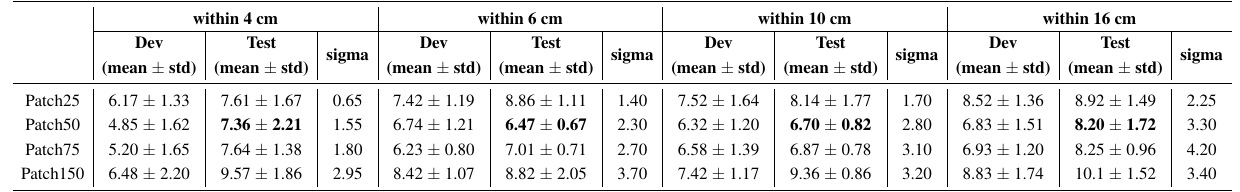
Figure A2. ROC curves of the power histogram features (DoF ( a ) within 4 cm, ( b ) within 6 cm, ( c ) within 10 cm and ( d ) within 16 cm). Table A5. HTERs (%) of GLOH features (overlap, PCA 90%).